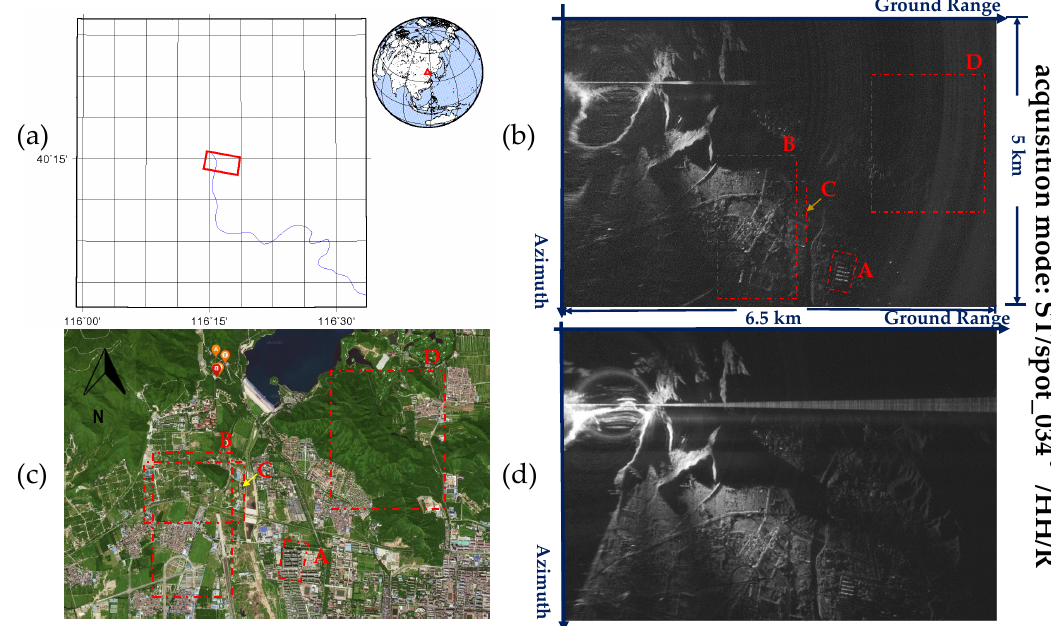
Figure 9. The images of the interested area: areas marked as A, B, C and D have been highlighted. ( a ) The location of the illuminated areas (provided by DLR); ( b ) the uncompensated BiSAR image; ( c ) optical image (provided by Baidu map); ( d ) the improved BiSAR